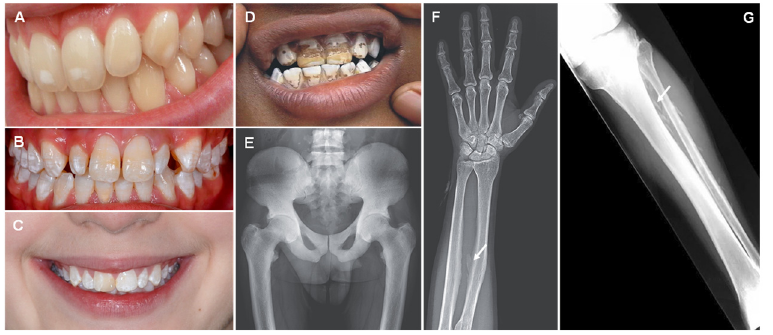
Figure 4. Dental fluorosis: mild ( A ), moderate ( B , C ), and severe ( D ). Pelvic radiography showing osteosclerosis ( E ). X-ray with arrows showing skeletal fluorosis evidenced by the diffuse bone condensation and interosseous membrane calcification of the forearm ( F ) and leg ( G ). Reprinted from ( B )—[127], ( D )—[128], ( E , F )—[129], ( G )—[126].